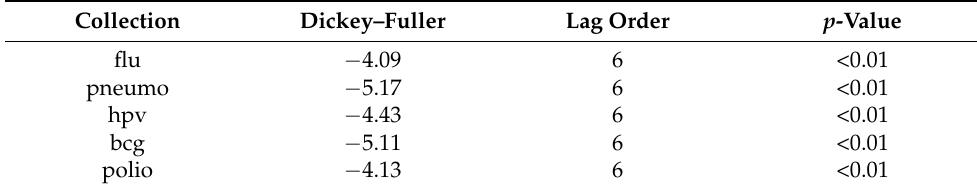
Table 2. Augmented Dickey–Fuller test results.